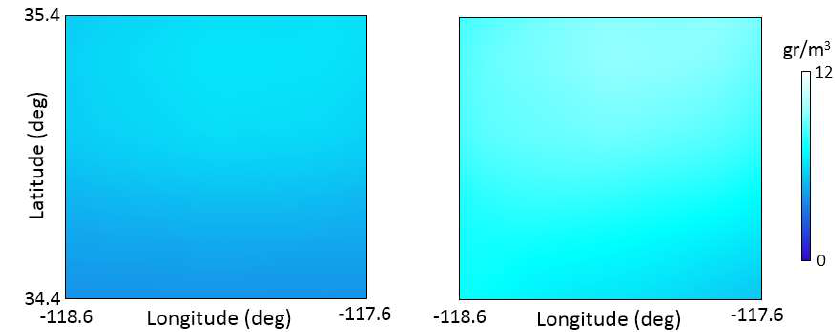
Figure 8. Obtained water vapor density (WVD) from the WRF model at a pressure level of 900 mb at two sample epochs .